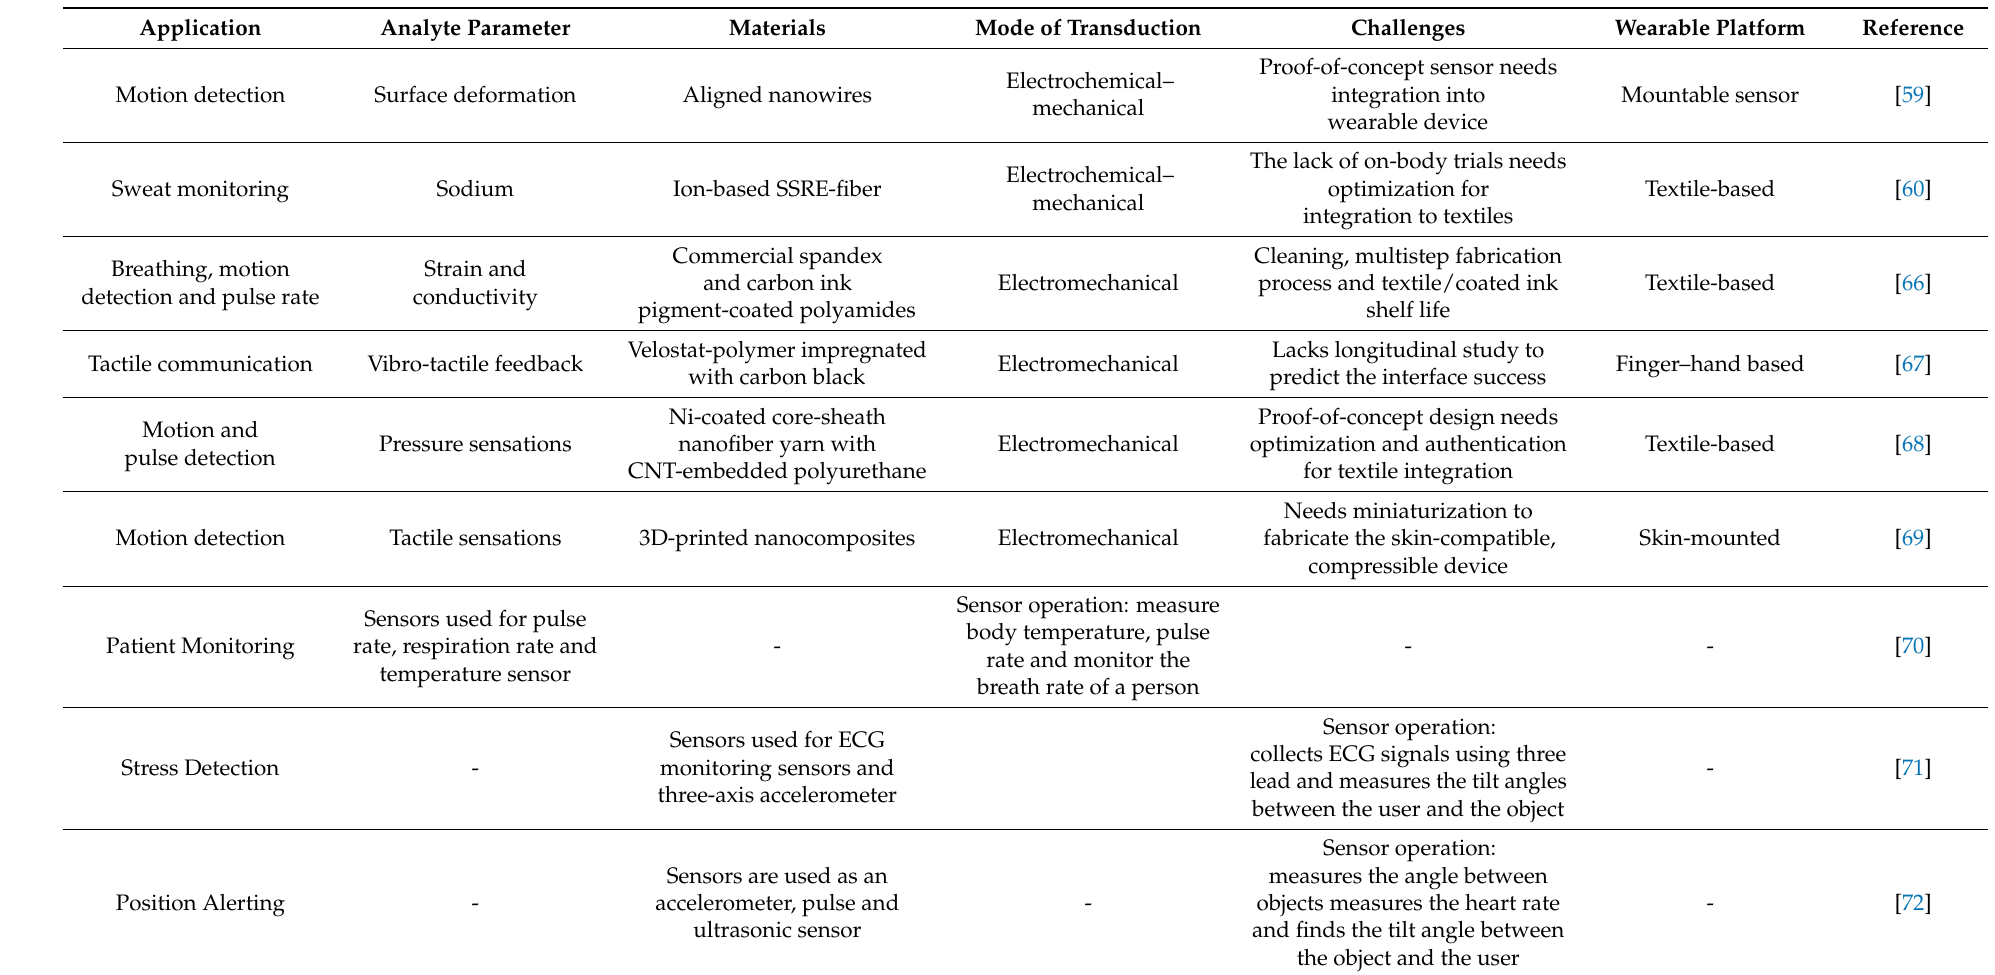
Table 1. A summary of the application of wearable sensors in